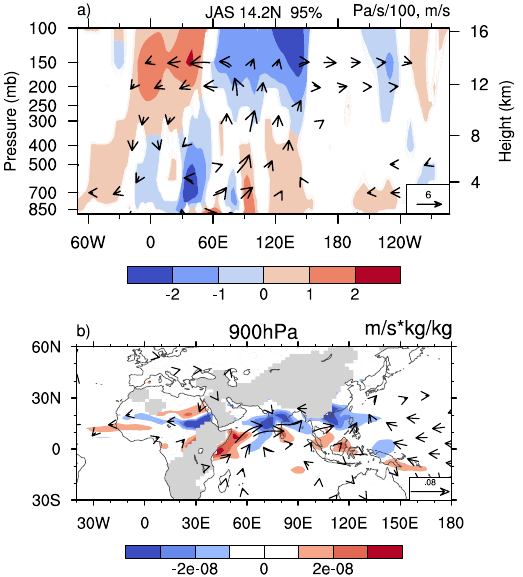
Figure 3. Differences in JAS omega, zonal wind, meridional wind, and water vapor flux. Differences in JAS ( a ) omega, zonal wind (vector) and meridional wind (shading) at 14.2°N between SEN_A and CON, and ( b ) water vapor flux (vector) and its divergence (shading) at 900 hPa between SEN_E and CON. The meridional wind and vectors denote the regions where the changes are statistically significant at the 95% confidence level according to the t -test. Omega is scaled so that the vertical motion is visible. This figure was generated by the NCAR Command Language (Version 6.3.0) [Software]. (2016). Boulder, Colorado: UCAR/NCAR/CISL/TDD.